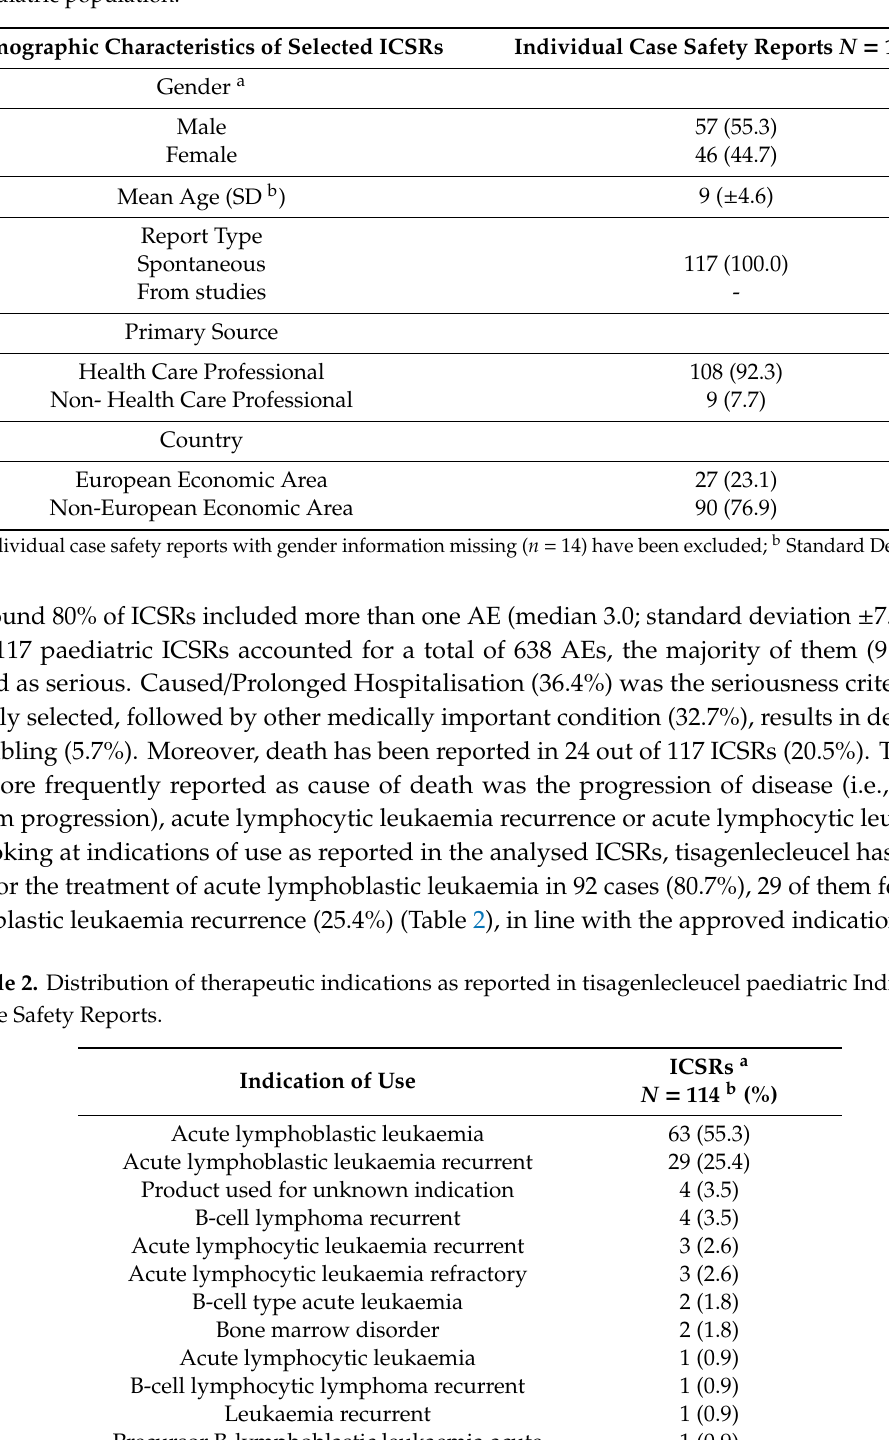
Table 1. Demographic characteristics of Individual Case Safety Reports involving tisagenlecleucel recognized in the Eudravigilance spontaneous reporting system from 2017–2020 in the paediatric population.